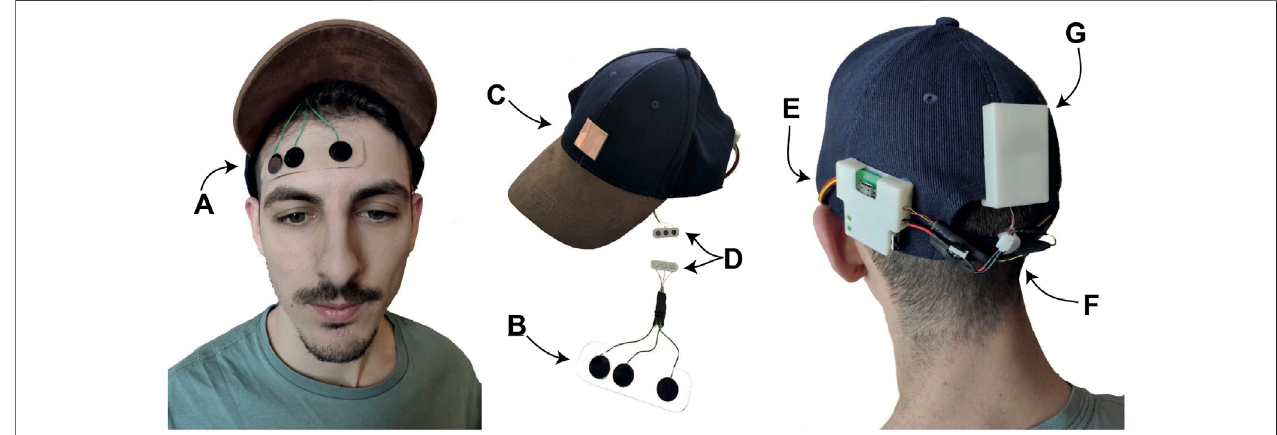
FIGURE 4 | The novel e-Cap. (A,B) 3D-printed electrodes by UT combined with the support for easy fi xation at the forehead. (C) Touch button for calibration procedure. (D) Magnetic connection for easy connection of the electrodes to the cap. (E) Control board. (G) Power supply. (F) Vibrotactile motor for haptic feedback.